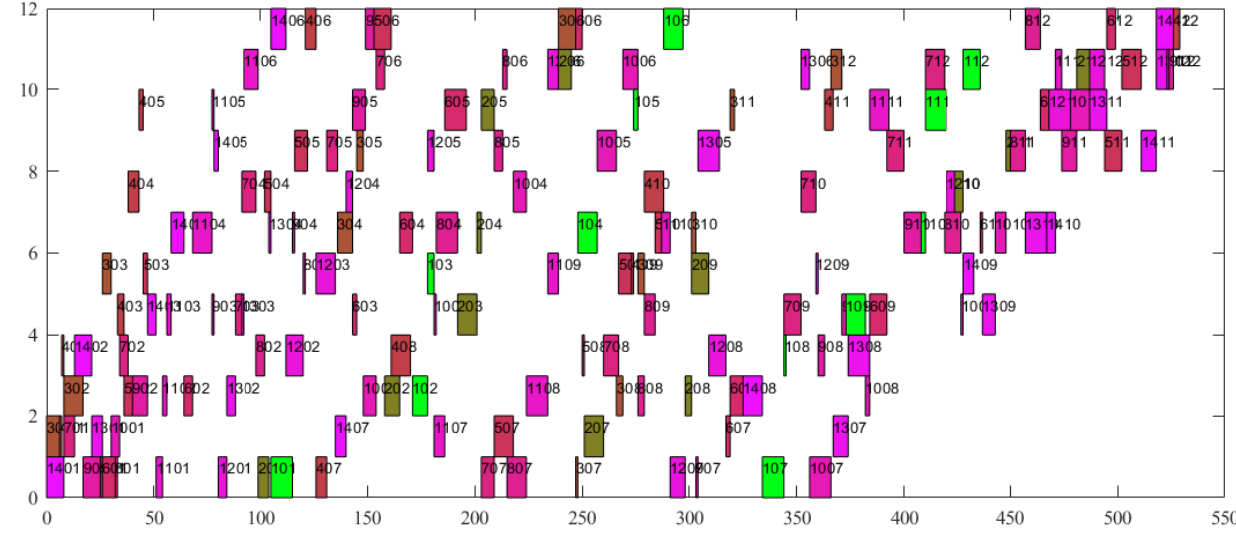
Figure 8. Scheduling-scheme Gantt chart.